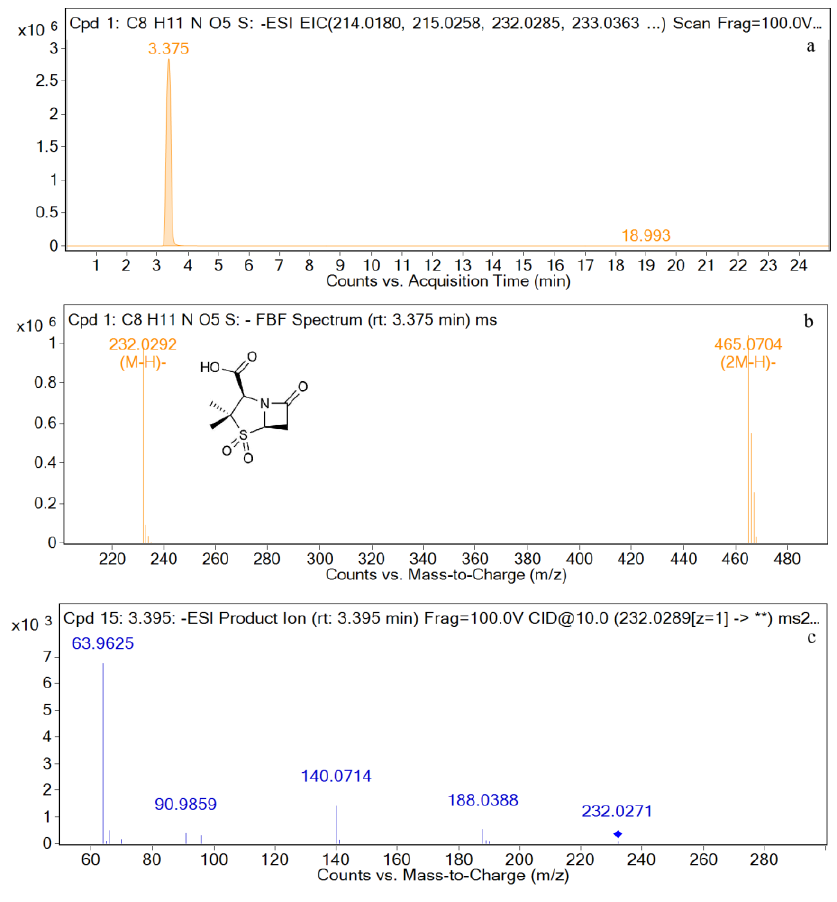
Figure 7. EIC and mass spectrometry results for Sulbactam. ( a ): EIC spectrometry results for sulbactam; ( b ): Mass spectrum of sulbactam; ( c ): Two-stage mass spectral data of sulbactam.